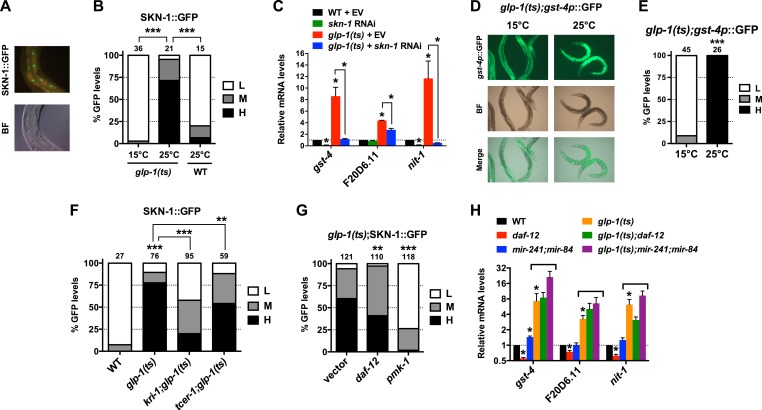
GSCs inhibit SKN-1 activity in the intestine.(A) Representative images of SKN-1::green fluorescent protein (GFP) in intestinal nuclei; GFP channel (top), bright field (BF; bottom). (B) Accumulation of SKN-1::GFP in intestinal nuclei in GSC(−) animals. (C) skn-1-dependent activation of direct SKN-1 target genes (Robida-Stubbs et al., 2012) in response to GSC absence, detected by qRT-PCR. (D, E) Increased expression of gst-4p::GFP in the intestine of glp-1(ts) animals. Hypodermal gst-4p::GFP expression appeared to be unaffected. (D) Representative 10× images. (E) Intestinal gst-4p::GFP quantification. (F–H) GSCs regulate SKN-1 parallel to DAF-16 and DAF-12. In (H), SKN-1 target genes are assayed by qRT-PCR. glp-1(ts) refers to glp-1(e2141ts), and horizontal black lines indicate strains lacking GSCs. (C, H) Data are represented as mean ± SEM. n = 3 for qRT-PCR samples. (B, E–G) GFP quantification with high, medium, low scoring. Numbers above bars denote sample size. p < 0.05*; p < 0.01**; p < 0.001***.